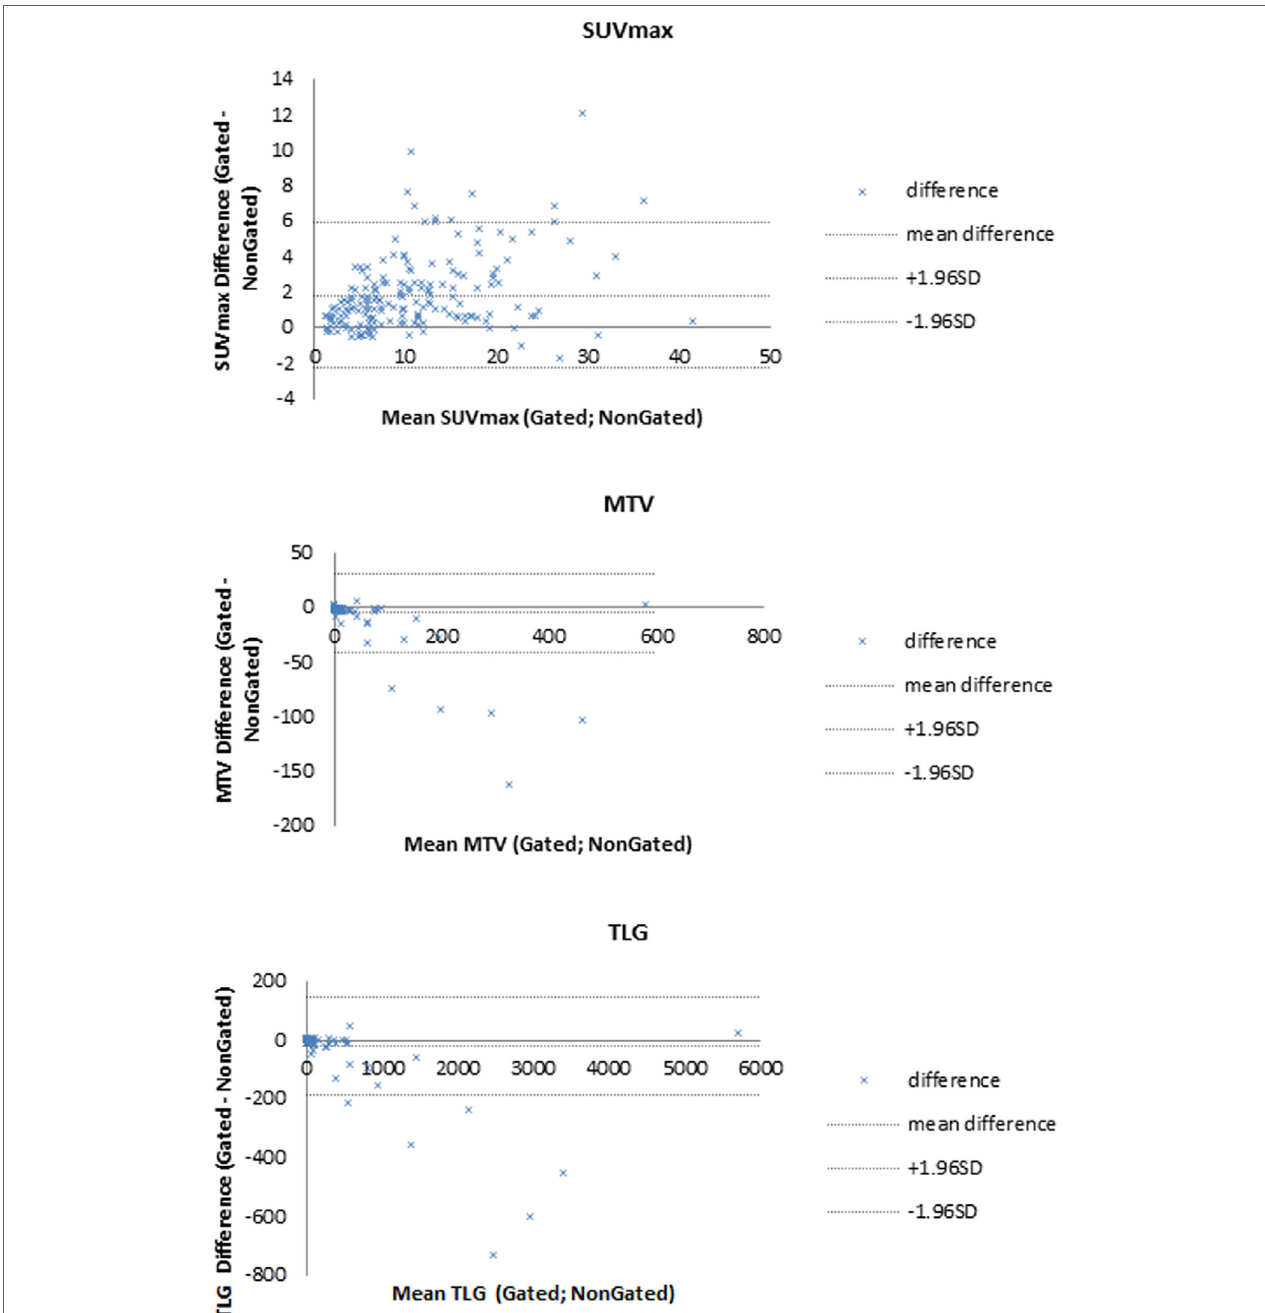
FigUre 6 | Bland–Altman plots for SUVmax, metabolic tumor volume (MTV), and total lesion glycolysis